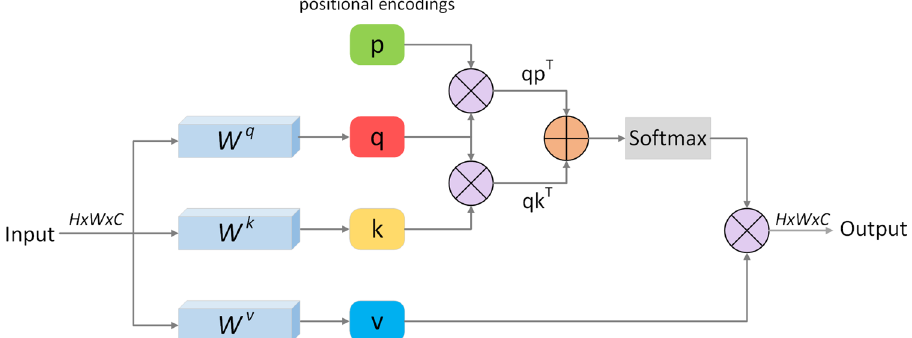
Fig. 9 The structure of MHSA